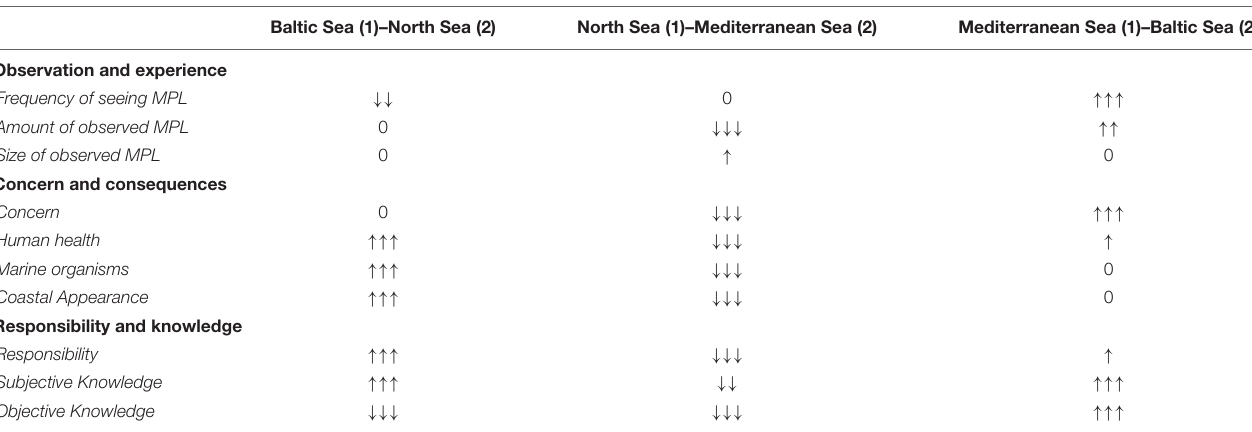
TABLE 2 | Comparisons of public responses on perception components by marine